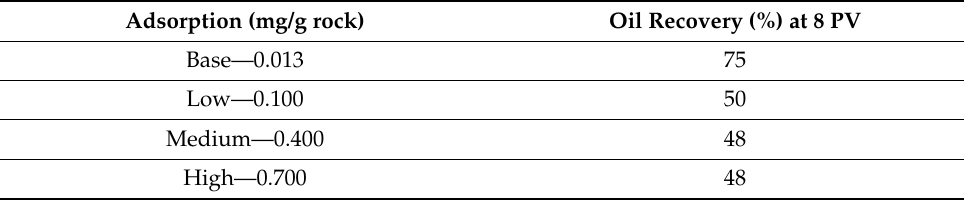
Figure 16. Tertiary oil recoveries at various adsorption levels. Table 11. Effects of Adsorption on Oil Recovery.